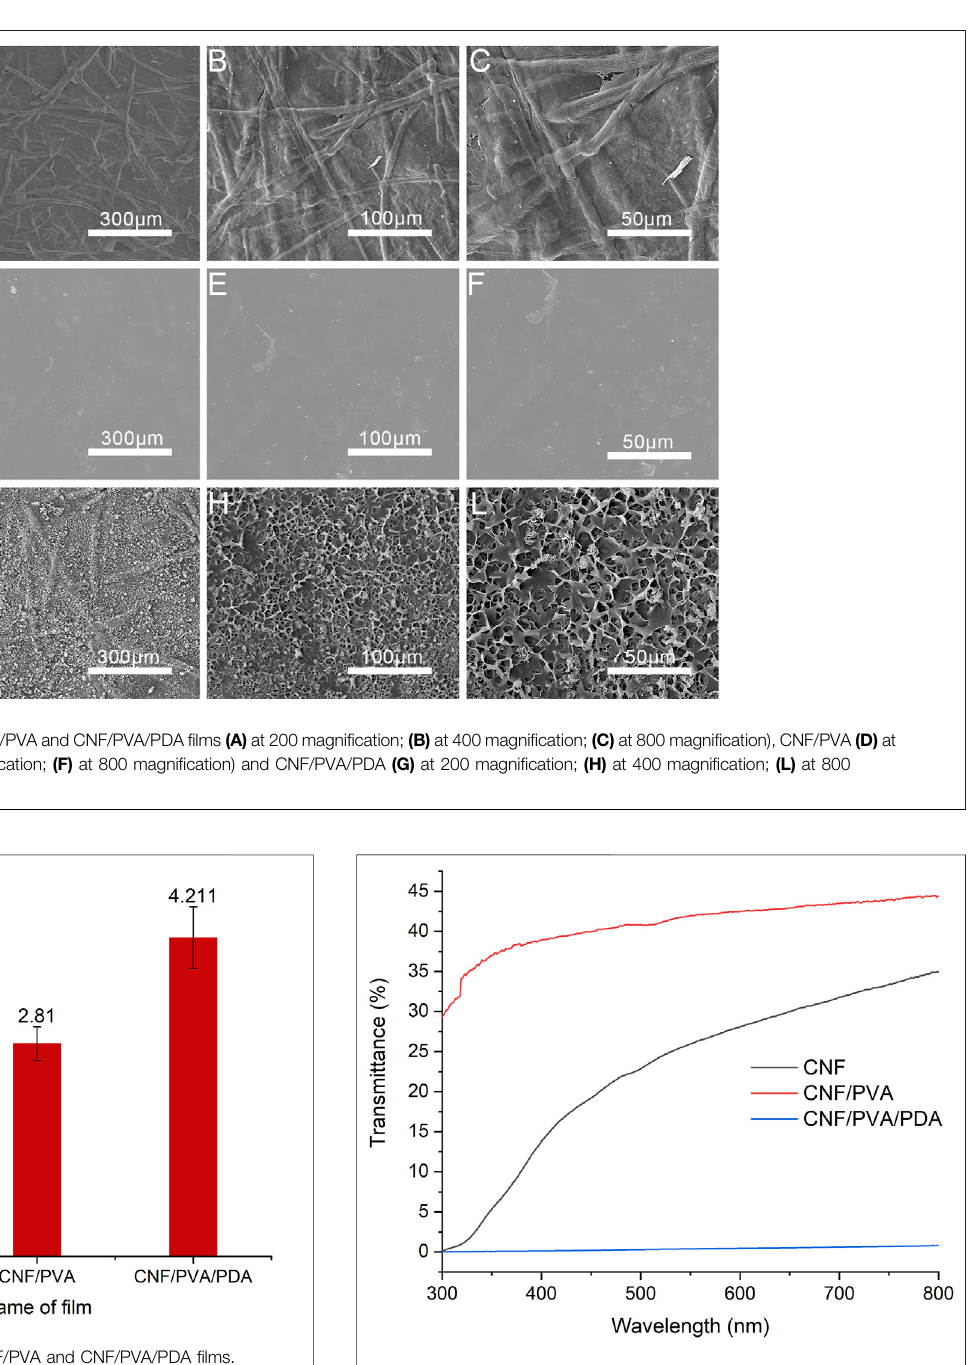
FIGURE 5 | Light transmittances of CNF, CNF/PVA, and CNF/